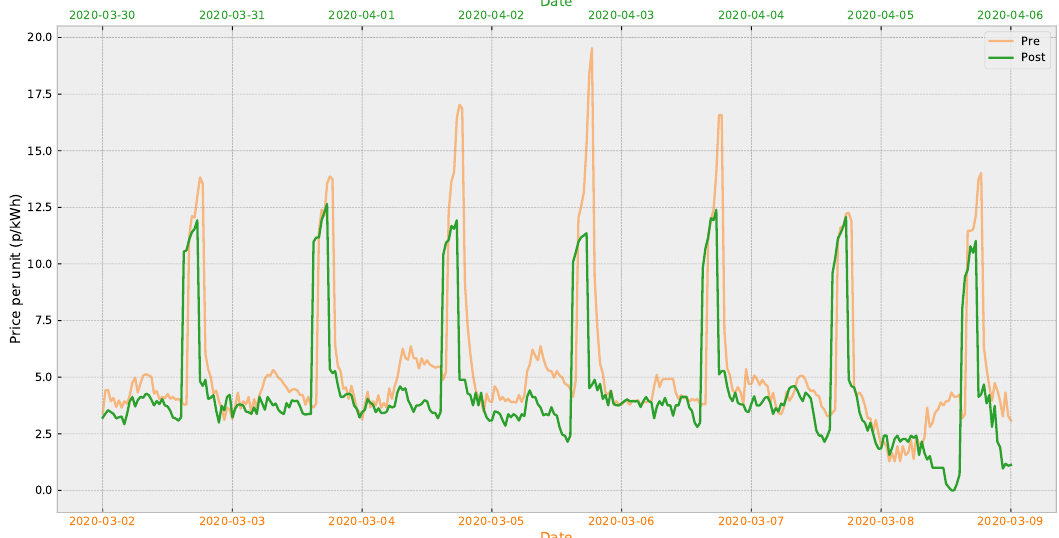
Figure 19. Corresponding agile outgoing sell prices using the data from [37], that show a high sell price reflecting the reserve scarcity (5 March 2020 on the lower orange x-axis) and a capped price of 0p/kWh (5 April 2020 on the higher green x-axis).